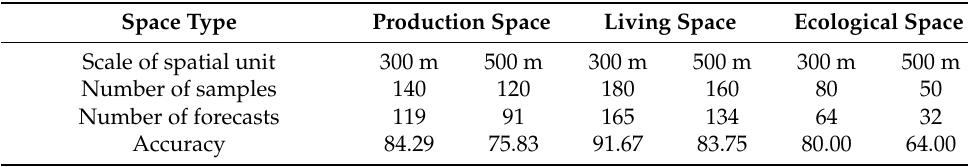
Table 3. The forecast accuracy of the random forest model at different